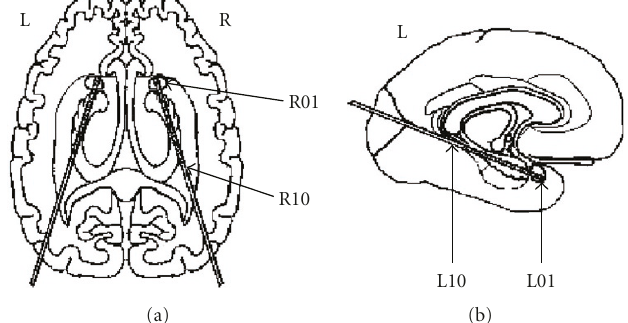
Figure 2: Schematic of intracranially implanted depth electrodes. (a) Axial view; (b) sagittal view. Each catheter-like, 1-mm-thick silastic electrode contains 10 cylindrical contacts of a nickel-chromium-alloy (2.5mm) every 4mm.